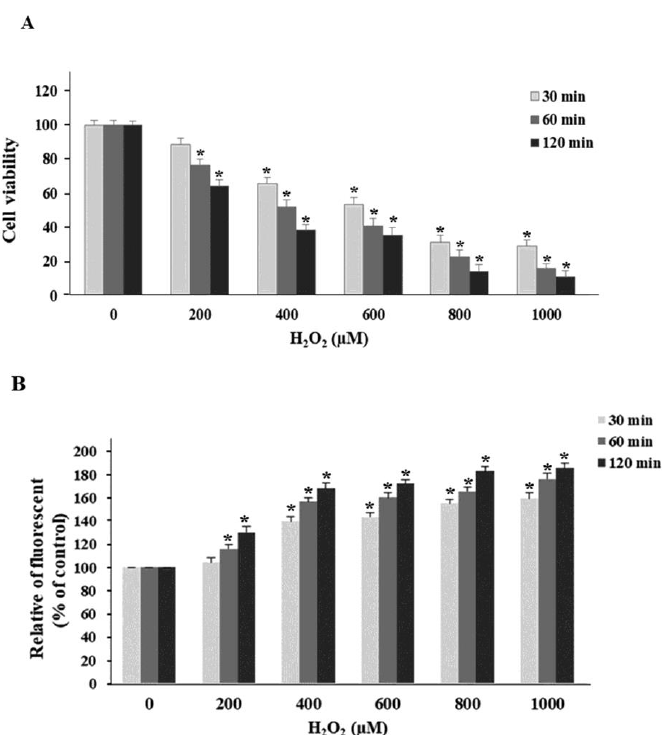
Figure 4. Evaluation of the effect of H 2 O 2 on cell viability and ROS production of ARPE-19 cells. Cells were treated at various concentrations of H 2 O 2 (200 – 1000 µM) for 30, 60 and 120 min. ( A ) Cell viability and ( B ) ROS production were measured using MTT and DCFH-DA assays, respectively. Results present cell viability and relative fluorescence related to ROS production as mean ± SD ( n = 4). The symbol * indicates significantly different from the control group ( p <